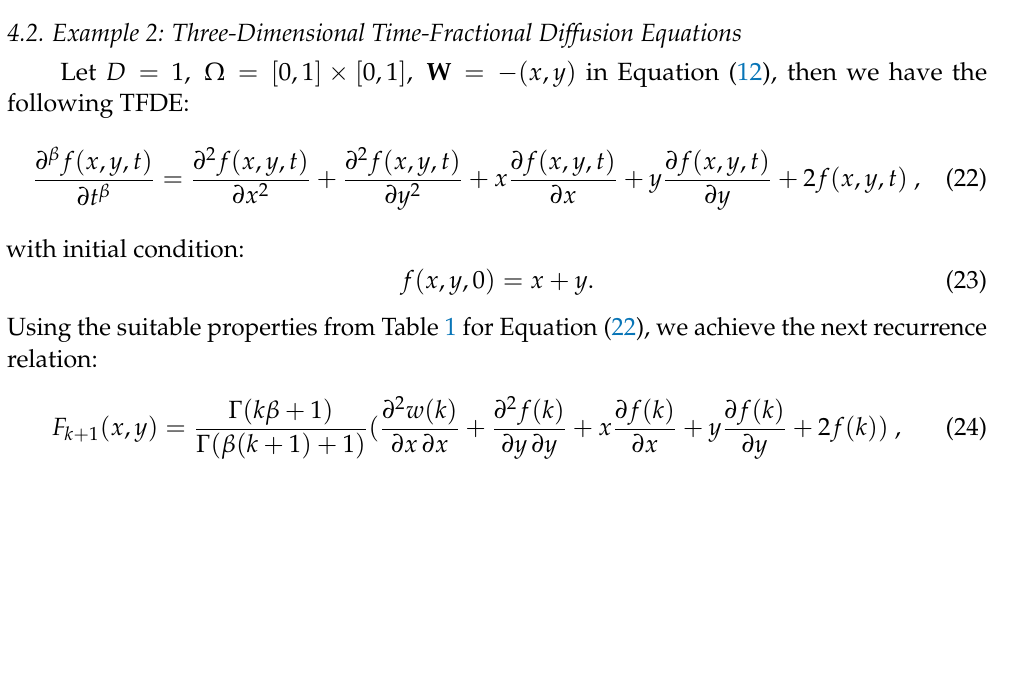
Figure 4. The FRDTM solutions f ( x , t ) for different values of x ; β = 1 and t ∈ [ 0,1 ]